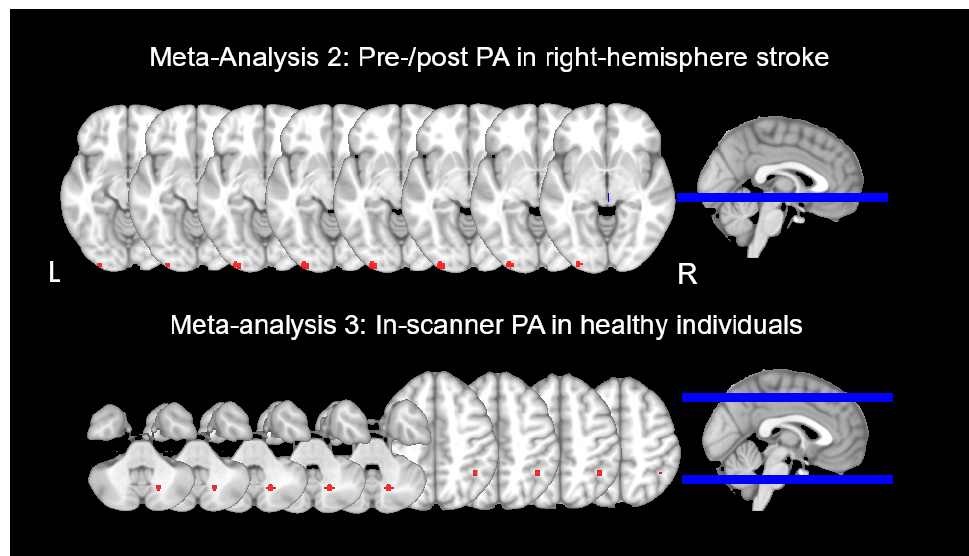
Figure 2. Significant clusters of activation identified using meta-analyses as implemented in Brainmap GingerALE software version 3.0.2 with a family-wise error rate of 0.01, 1000 permutations, and minimal cluster threshold of 200 mm 3 . Images are presented in neurological orientation; laterality is identified with letters L for left and R for right side of the